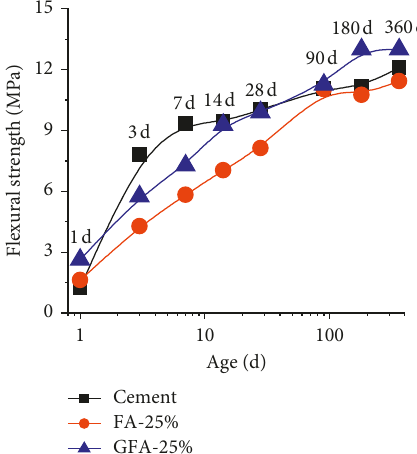
Figure 7: The flexural strength versus ages.